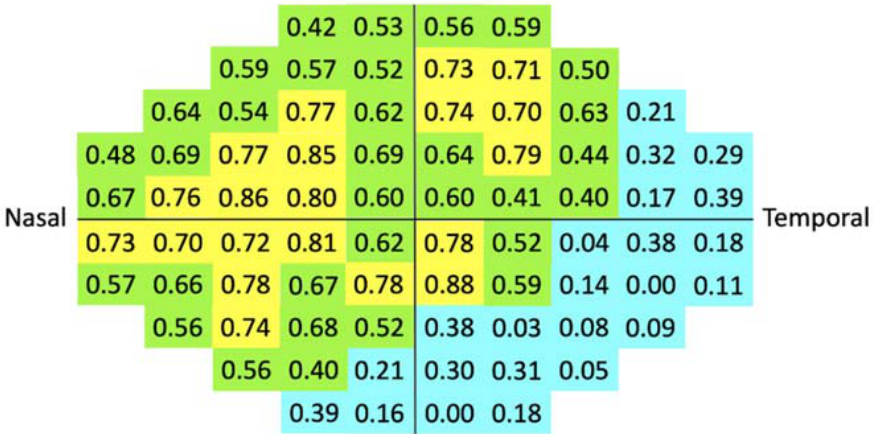
Figure 4. Correlations of 76 test locations between LUXIE and Humphrey Field Analyzer 3 shown on central 30 ◦ visual field grids. Strong ( r ≥ 0.7), moderate (0.7 > r ≥ 0.4), and weak correlations ( r < 0.4) were marked as yellow, green, and blue, separately.